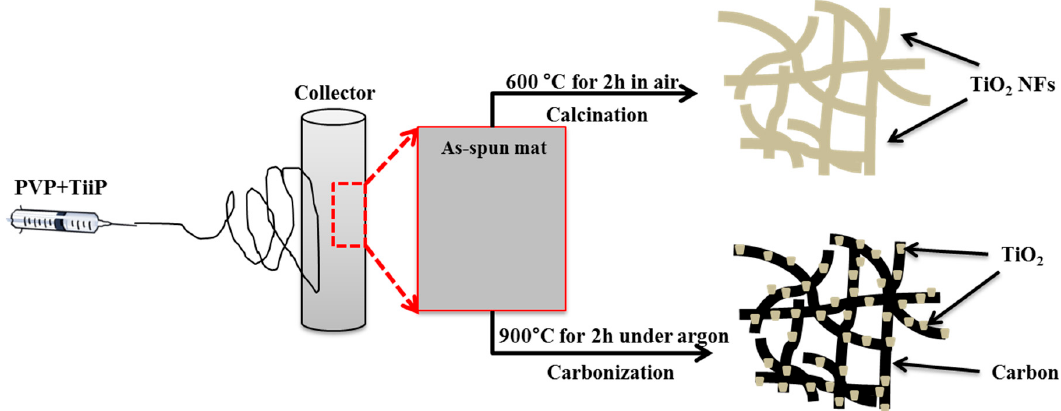
Figure 1. Synthesis protocol of pristine titanium dioxide nanofibers (TiO 2 NFs) and TiO 2 -carbon